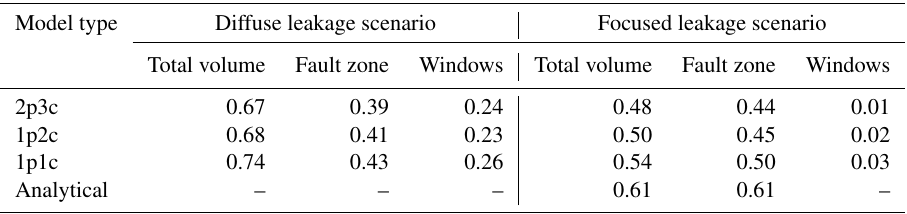
Figure 16. Diffuse leakage scenario: high diffuse migration over the barrier (Upper Buntsandstein barrier permeability is 1 × 10 − 18 m 2 ). Top row: volumetric flow over the hydrogeological windows and the fault zone. Bottom row: pressure buildup at measurement points M1 and M2. Table 4. Fluid volumes displaced into the target aquifers during 100 years of injection over different vertical pathways. The volumes are normalized by the injected volume. Two scenarios are considered: (i) diffuse leakage through the Upper Buntsandstein barrier (UBS) ( k = 10 − 18 m 2 ) and (ii) focused leakage (UBS permeability k = 10 − 20 m 2 ). Note that the total volume may be slightly higher than the sum of the volumes displaced over the fault zone and the hydrogeological windows, as a small fraction of the volume is displaced over the intact Rupelian clay